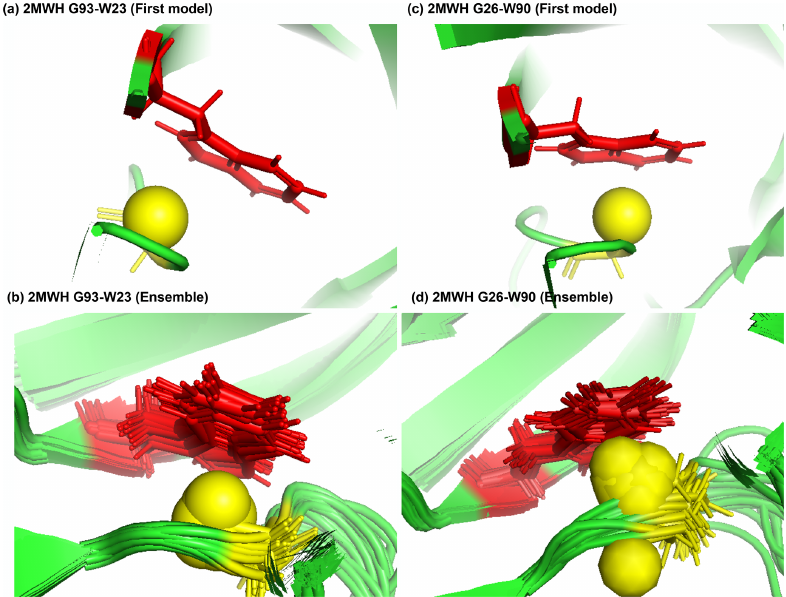
Figure 7. Examples of amide protons with extreme upfield shifts. (a, b) PDB:2MWH. The G93 amide proton is directly below the W23 aromatic ring ( Z =− 7, δ GLY = 2.937ppm, d = 3.99Å, θ = 43.9 ◦ , δ GLY = 8.237ppm, σ GLY = 0.770ppm). (c, d) PDB:2MWH. The G26 amide proton is directly below the W90 aromatic ring ( Z =− 6.43, δ GLY = 3.38ppm, d = 2.98Å, θ = 25.0 ◦ , δ GLY = 8.327ppm, σ GLY = 0.770ppm). The amide proton is represented as a yellow sphere, and the aromatic sidechain is shown in red.